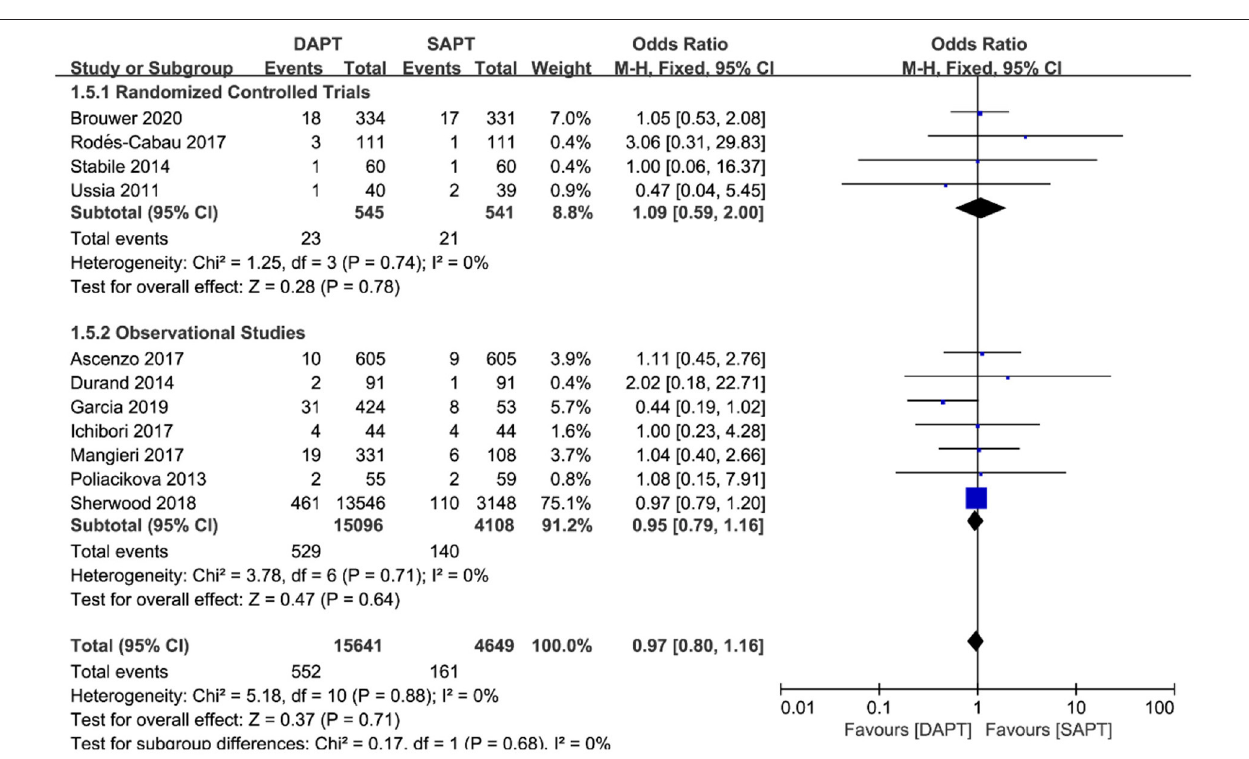
Frontiers in Cardiovascular Medicine |